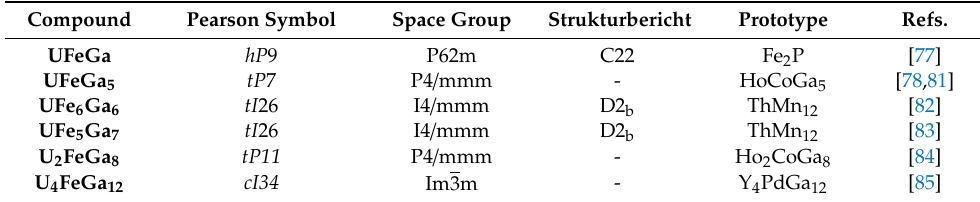
Table 3. Crystal Structure of U-Fe-Ga intermetallic